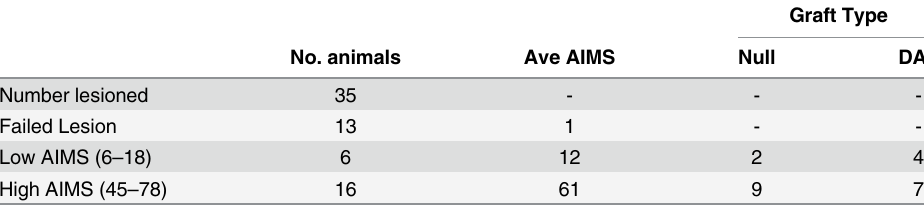
Table 1. Animals Used in the